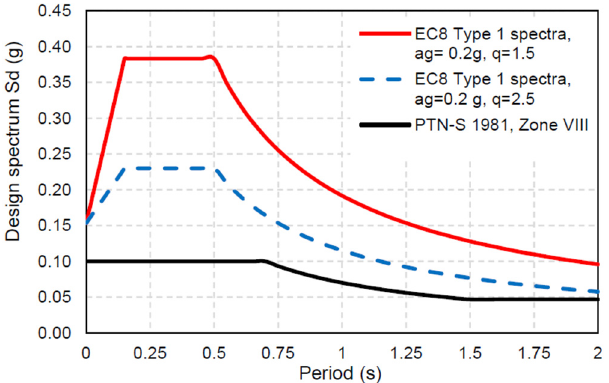
Figure 18. Design response spectra for Kraljevo, Serbia, according to Eurocode 8 (a g = 0.2 g, ground type B, q = 1.5 and q = 2.5) and PTN-S code (seismic intensity VIII, soil Category II—valid at the time of the 2010 earthquake).